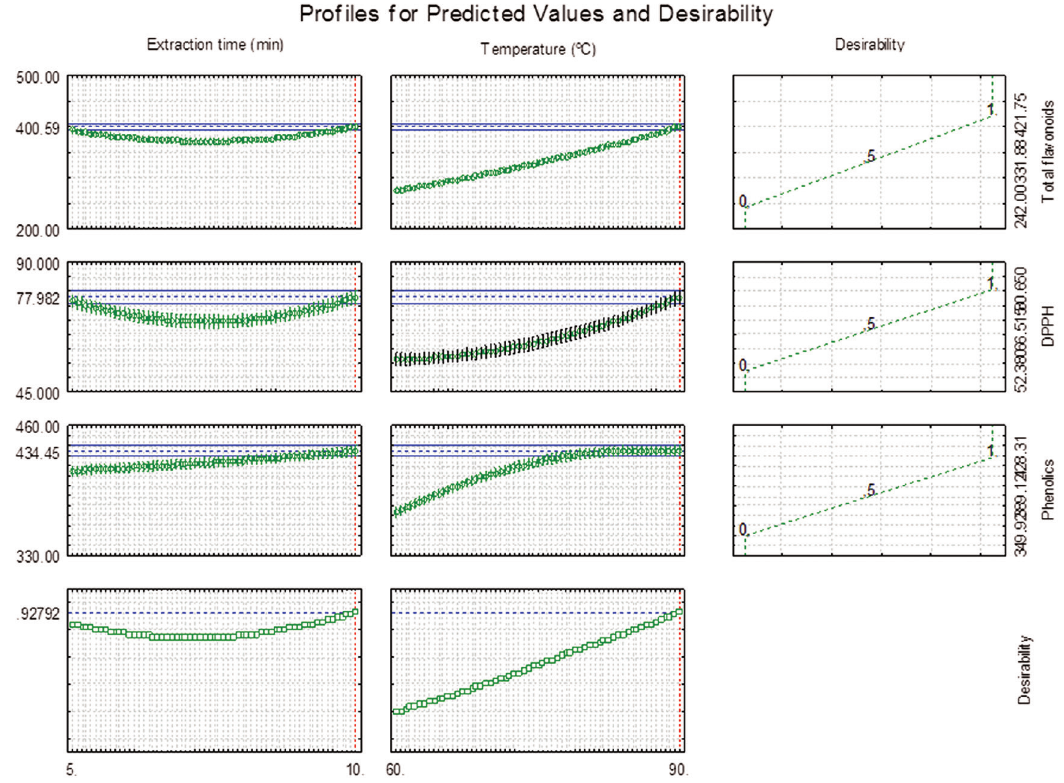
Figure 3 - Optimization of bioactive compounds from roasted yerba mate leaves using the desirability function (Derringer and Suich